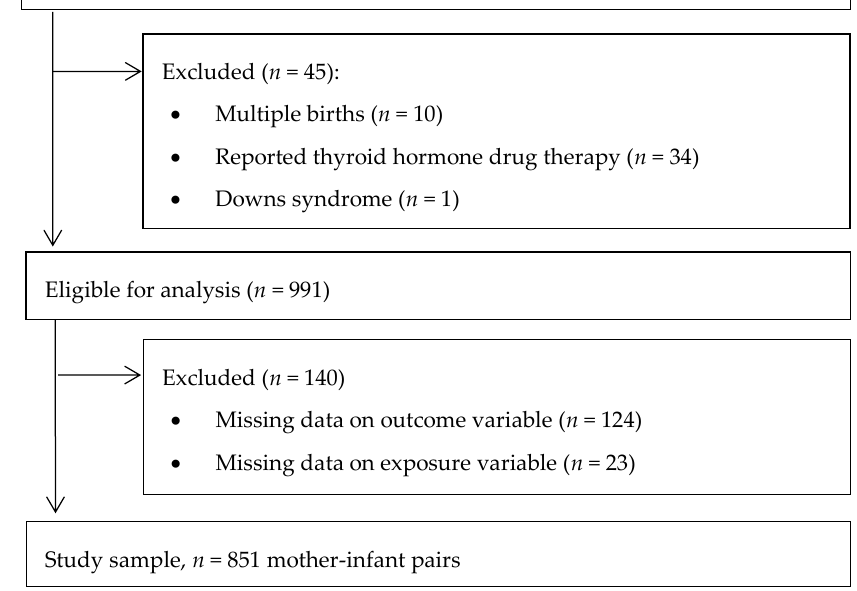
Figure 1. Flow chart showing the study population.